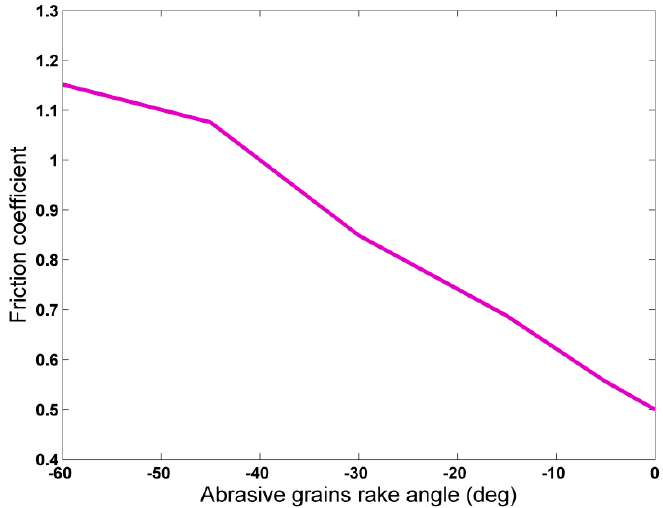
Figure 7. Average friction coe ffi cient values in respect to abrasive grains rake angle.